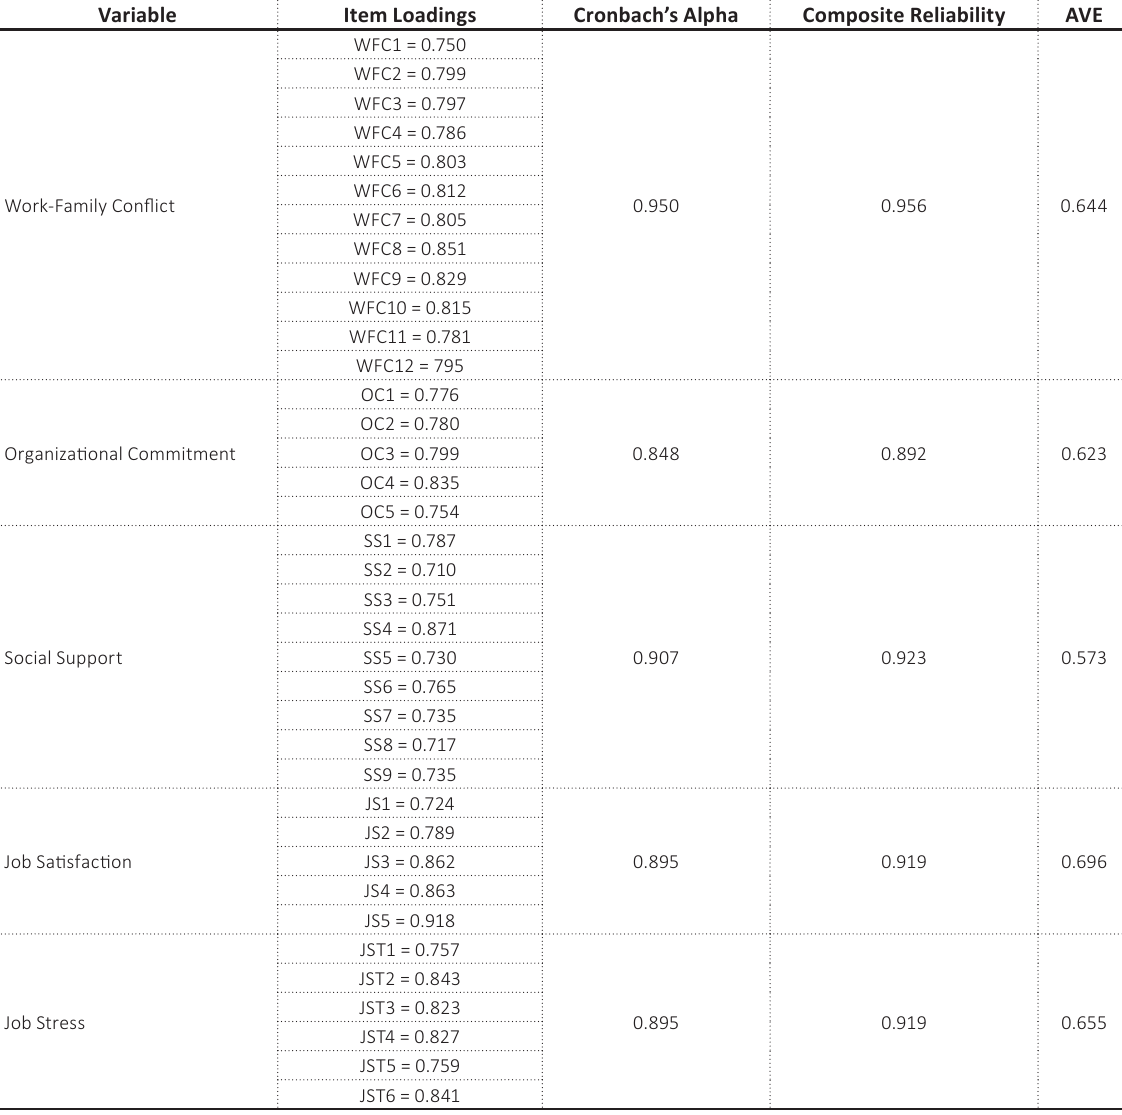
Table 2. Validity and reliability